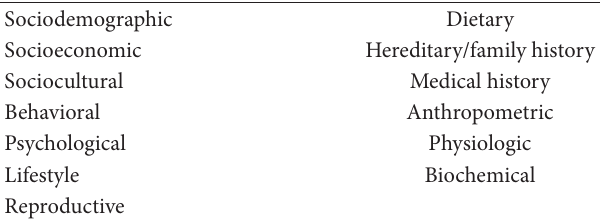
Table 4: Types of data collected in reviewed